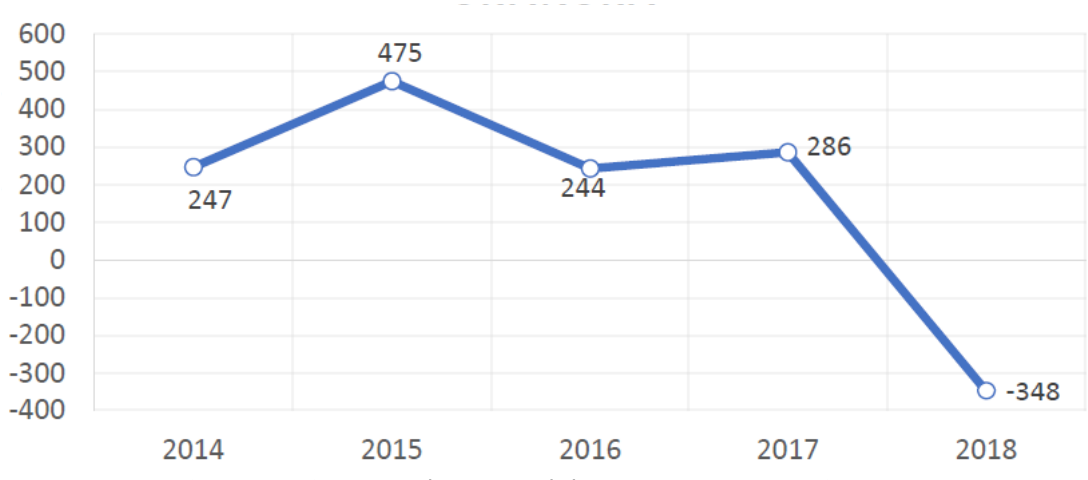
Figure 5: Earnings before taxes of SKANSKA (CZK million), (source: Annual report of SKANSKA 2014-2018, data processed by the